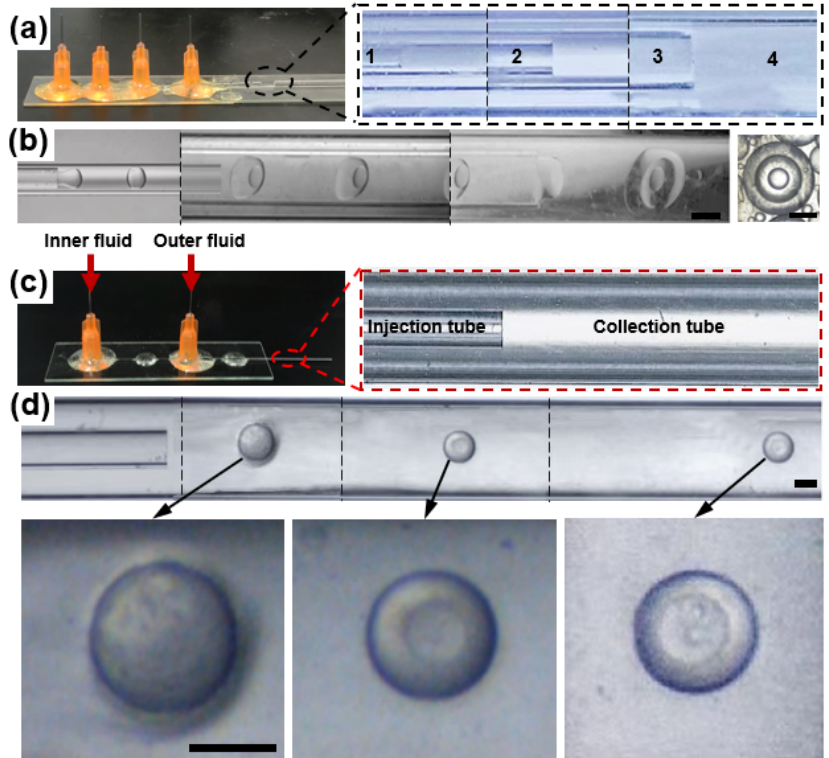
Figure 1. ( a ) Digital photographs of the microfluidic device with four cylindrical glass capillary tubes. From the inside out, each number represents a glass capillary. To make droplets with three layers, four cylindrical glass capillary tubes are needed to be arrayed into a critical structure. ( b ) The optical microscopic image of the process to produce droplets with three layers. The droplet produced by the device is shown to the right. Scale bar = 500 µm. ( c ) Microfluidic device with a co-flow structure. It was composed of two cylindrical glass capillary tubes called the injection tube and the collection tube, respectively. When using it to prepare droplets, inner fluid and outer fluid are injected into the injection tube and the collection tube by syringe pumps, respectively. ( d ) The optical microscopic image of the process to produce droplets with different layers. Scale bar = 200 µ